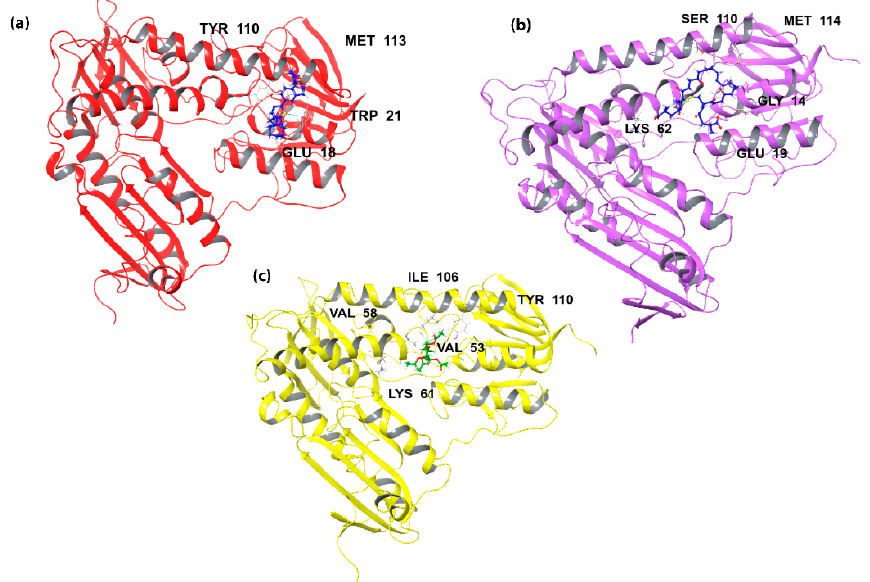
Figure 3. Trypanothione crystal structures with co-crystallized ligands. The residues of all the active sites are indicated in each figure. ( a ) T. brucei trypanothione ( b ) T. cruzi trypanothione ( c ) L. infantum trypanothione. Table 3. Targets and related agents against ΗΑΤ .